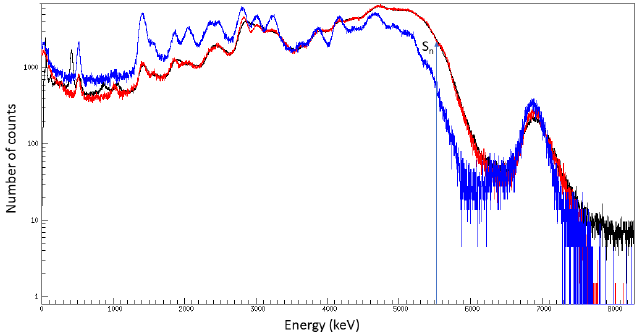
Figure 4. Experimental total energy deposited in MTAS detector emitted in the decay of 87 Br (black) compared with the simulated detector response based on ENSDF data (blue) and the simulated detector response based on the result of the analysis